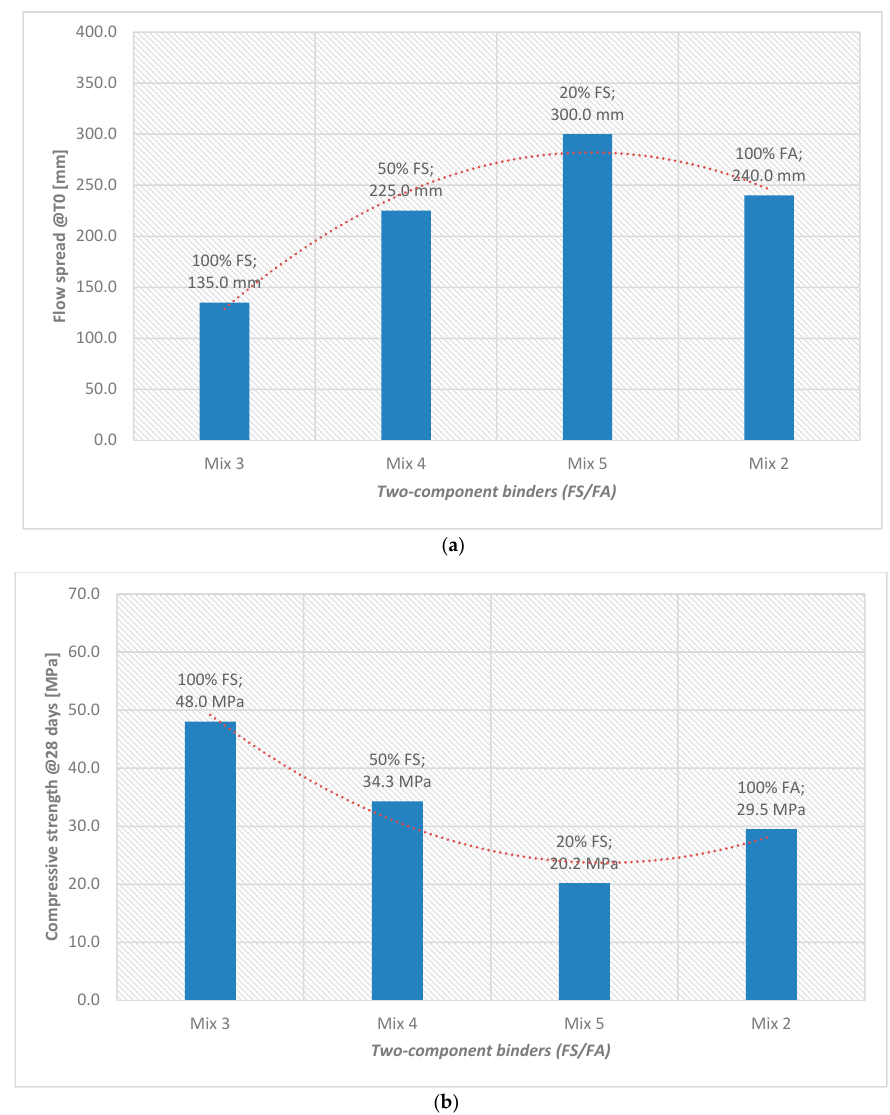
Figure 4. Technical performance comparison for mortars based on furnace slag/fly ash blends: ( a ) flow spread and ( b ) compressive strength at 28 days.